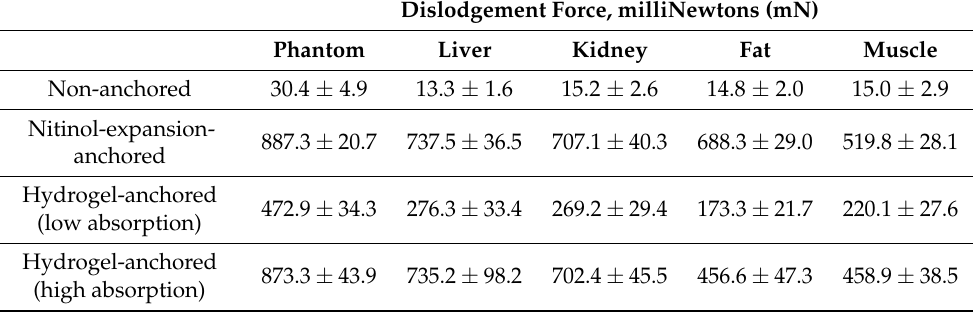
Table 1. Maximum forces required to dislodge IMDs based on tissue type and anchoring method. Mean and standard error of mean (SEM) values are